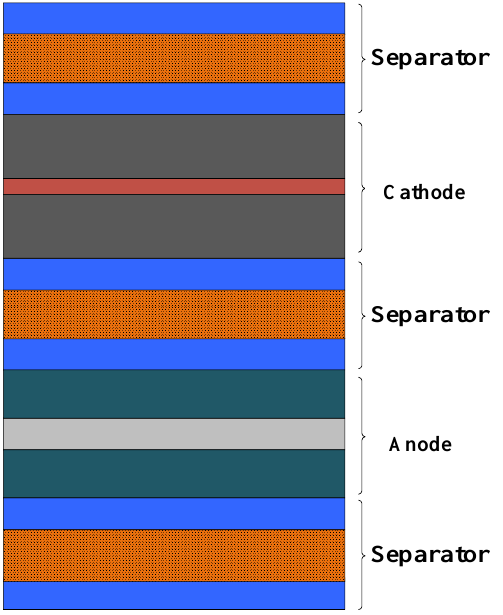
Figure 5. The homogenization model of the lithium-ion battery core.